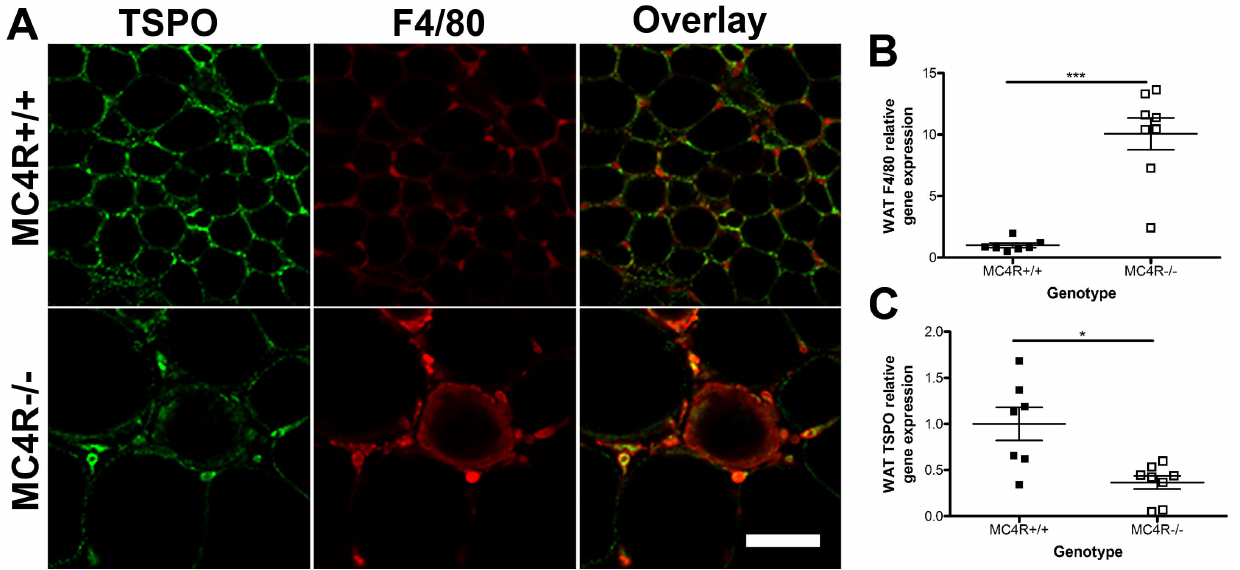
Figure 4. TSPO is expressed in adipocytes and white adipose tissue macrophages. TSPO (green) and macrophage marker F4/80 (red) co- localize in cells surrounding adipocytes in MC4R 2 / 2 WAT (Overlay, bottom panel). F4/80 mRNA levels were significantly higher (B) and TSPO significantly lower (C) in MC4R 2 / 2 mice as compared to their lean MC4R + / + littermates. Data are expressed as mean 6 standard error (panels B and C). n=7–8 (panels B and C). Statistical significance of *p , 0.05 and *** p , 0.001 was determined by unpaired t-test. Scale bar=50 m